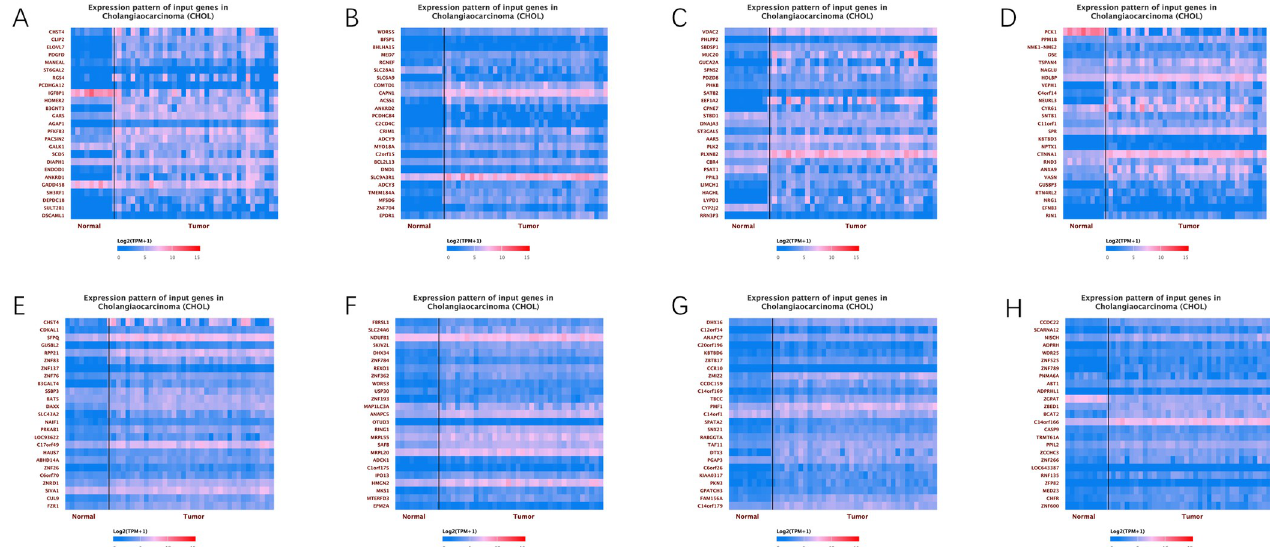
Fig 2. Expression pattern of correlated genes about CHST4 from the UALCAN. (A) top 1–25 genes positively correlated with CHST4 in CCA, (B) top 26–50 genes positively correlated with CHST4 in CCA, (C) top 51–75 genes positively correlated with CHST4 in CCA, (D) top 76–100 genes positively correlated with CHST4 in CCA, (E) top 1–25 genes negatively correlated with CHST4 in CCA, (F) top 26–50 genes negatively correlated with CHST4 in CCA. (G) top 51–75 genes negatively correlated with CHST4 in CCA. (H) top 76–100 genes negatively correlated with CHST4 in CCA. The red means high expression of genes and blue means low expression of genes in the heatmap.